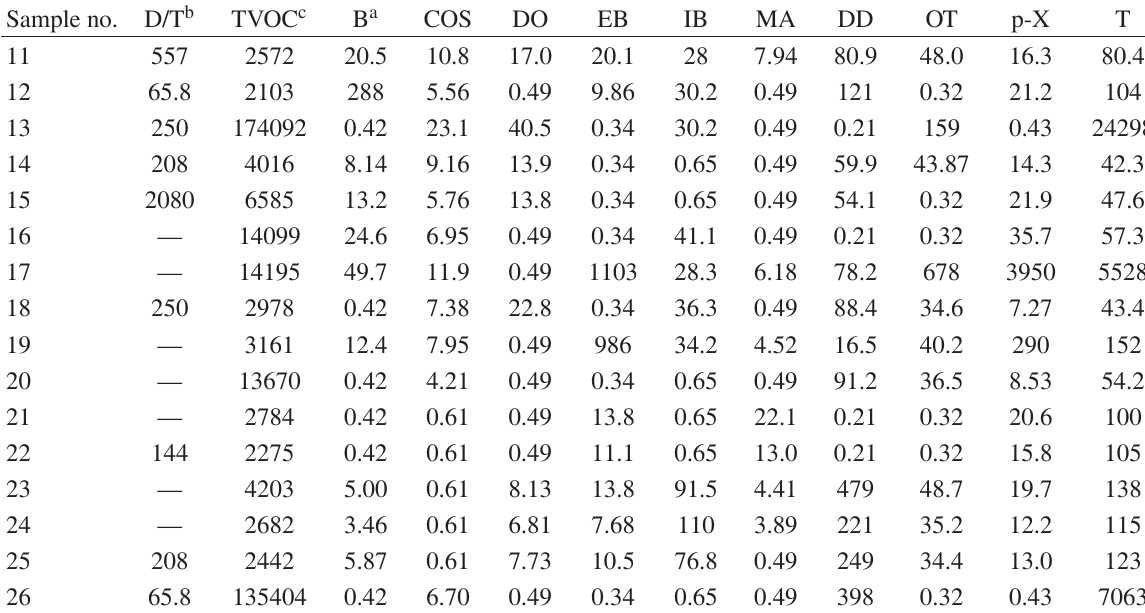
a For acronyms see Table 1. b D/T: Dilution to threshold ratio. (For some bags, D/T ratio was not measured and show with “—” marking.) c TVOC: Total VOC (sum of 25 target VOCs in this study) in